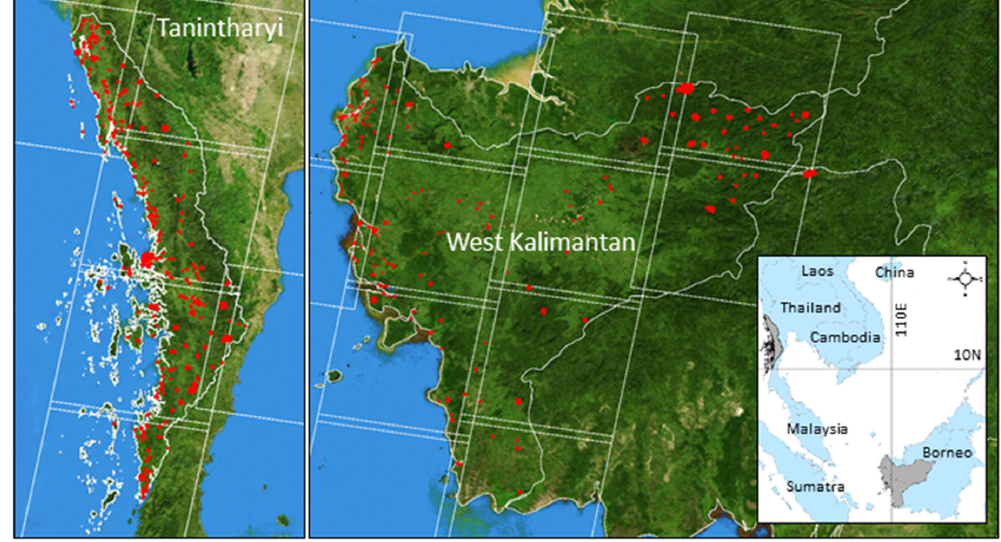
Figure 1. Tanintharyi, Myanmar and West Kalimantan, Indonesia study areas in tropical South/Southeast Asia with Landsat path rows overlaid and training and validation polygons highlighted in